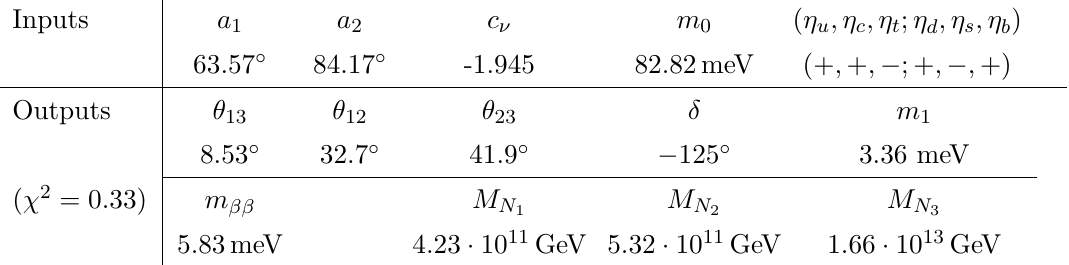
Table 6 . Inputs and predictions of neutrino masses and mixing parameters of BP1 fully satisfy all experimental data. Charged fermion masses and CKM mixing are all fixed at experimental best-fit values. Neutrino masses with normal ordering are